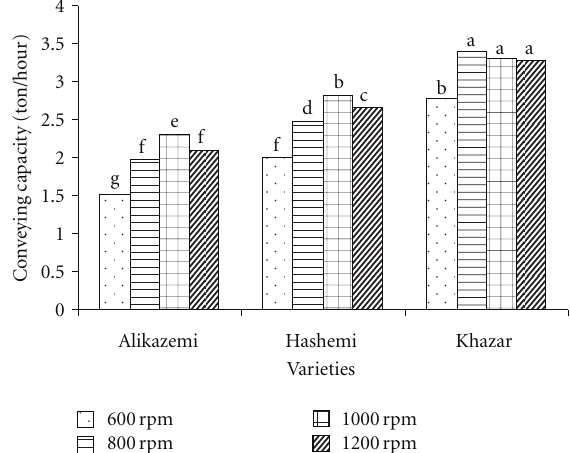
Figure 6: Mean comparison results of interaction e ff ects of variety and screw rotational speed on the conveying capacity (dissimilar letters show di ff erent significantly at probability level